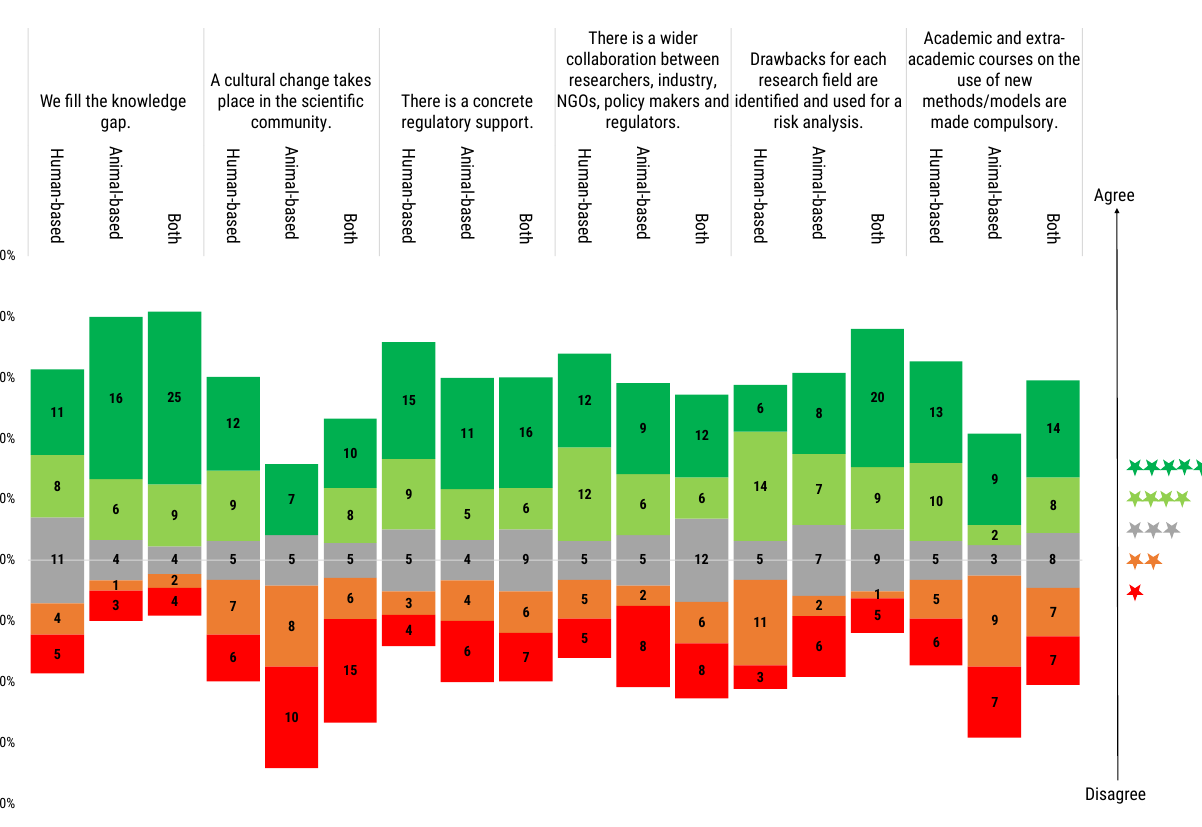
Figure 12. Participants were asked to rate the following statement, “Animal-based research should be phased out only if …”, completed with a set of different options regarding the gaps or barriers to overcome for phasing out animal experimentation. Rating scale was from 1 (red) to 5 (dark green) stars. Histogram dimensions are represented as 100%, where 100% is the total number of participants of each subgroup: human-based (39), animal-based (30) and both (44) model users. The stacked chart, calibrated around the neutral score (in grey, 3 stars), shows the number of respondents based on their degree of agreement and segmented by researchers’ use of animal- or human-based or both models.